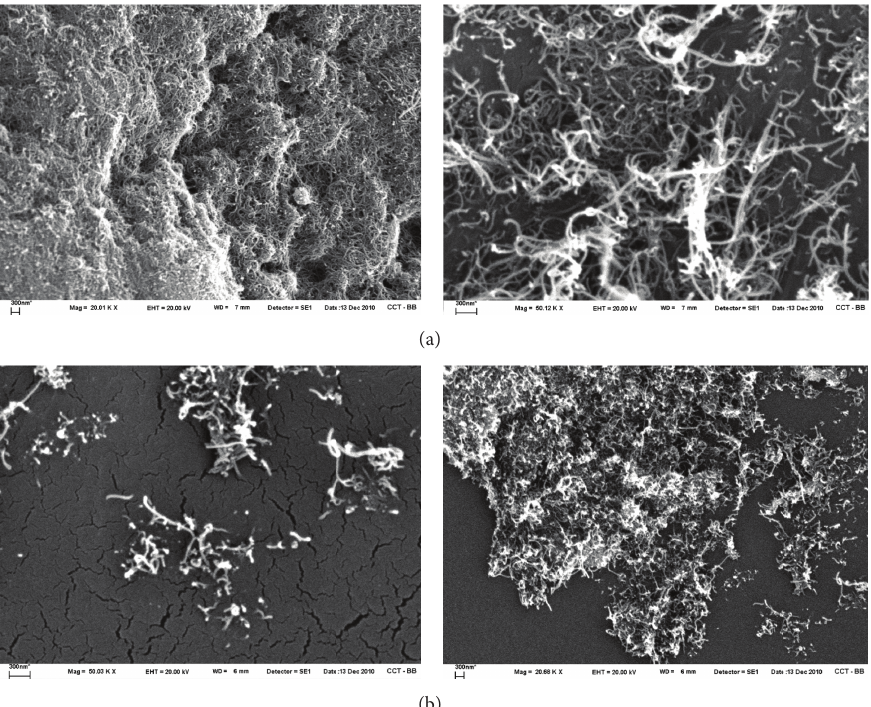
Figure 3: SEM images of MWCNTs (a) purified at 20000x and 50000x and (b) oxidized with HNO 3 at 20000x and 50000x. The scale in all figures is 300 nm.